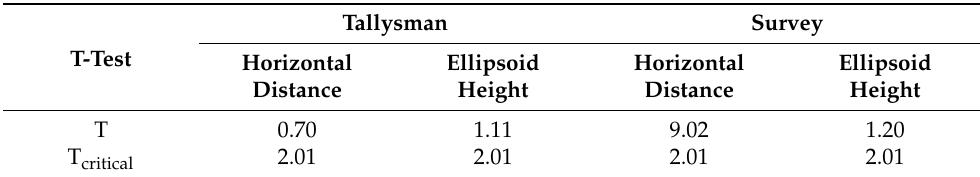
Table 6. The Results from the T-test.